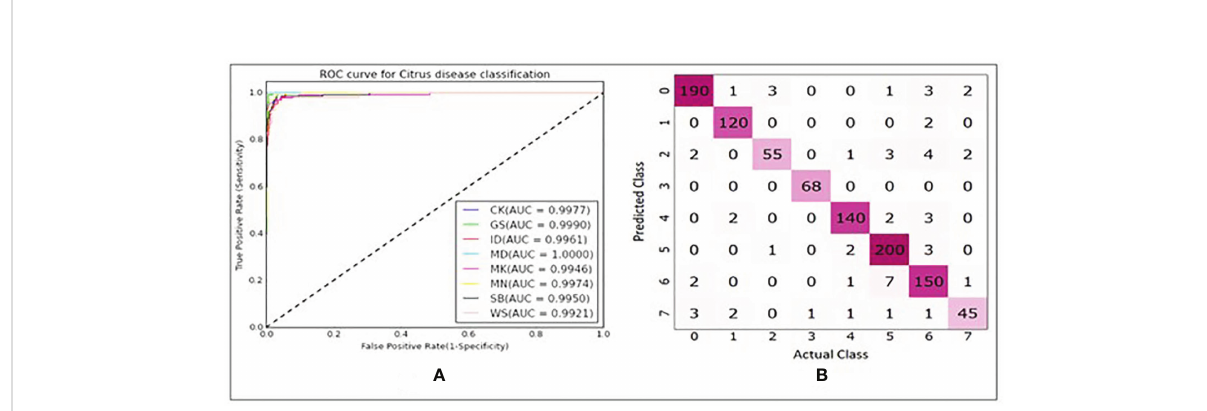
FIGURE 11 (A) ROC plots with corresponding AUC values for each class. (B) Confusion matrix showing number of correctly and misclassi fi ed images for each class(refer to Table 1 for class numbers along x and y